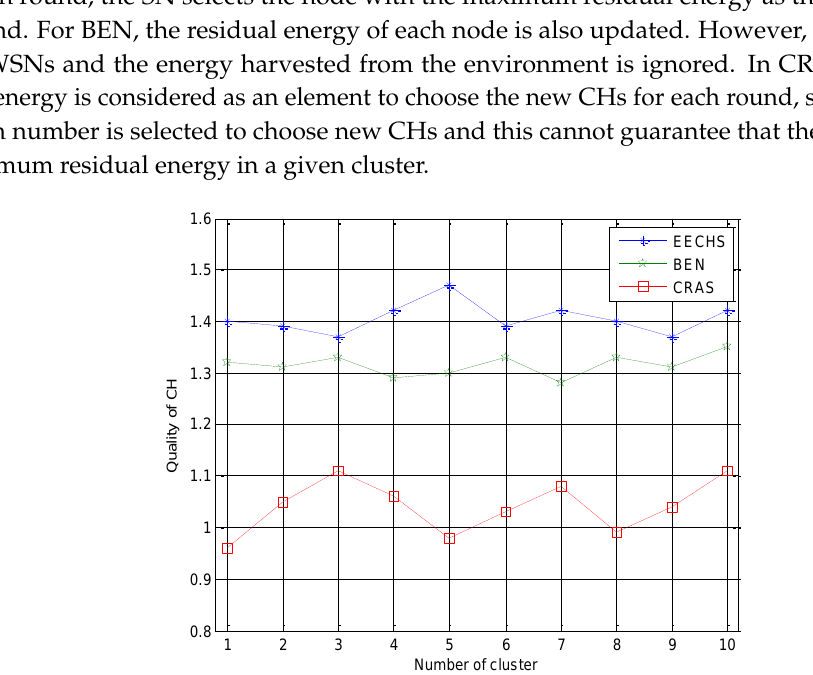
Figure 5. Experimental results for CH